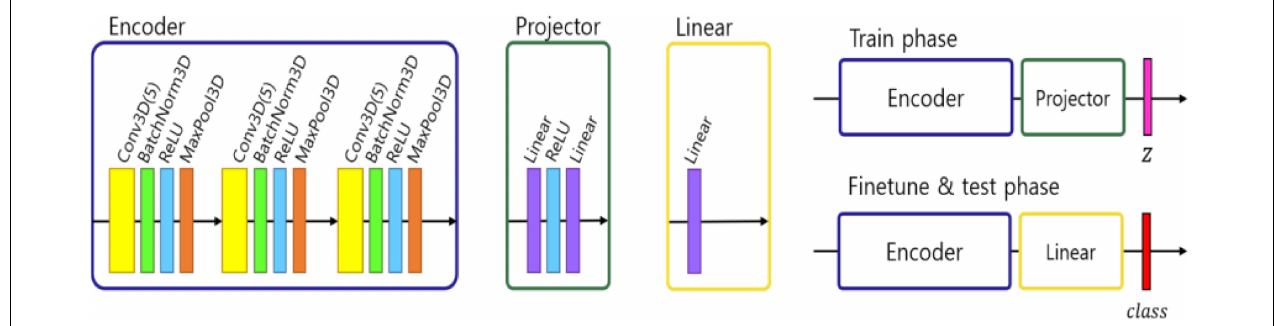
FIGURE 1 | Architecture of ML pipeline: encoder, projector, and linear module. In the training phase, an encoder and projector were used to project the images into representation space with a latent vector z. In the fine tuning and test phase, the projector was changed with a linear module and predict the class.